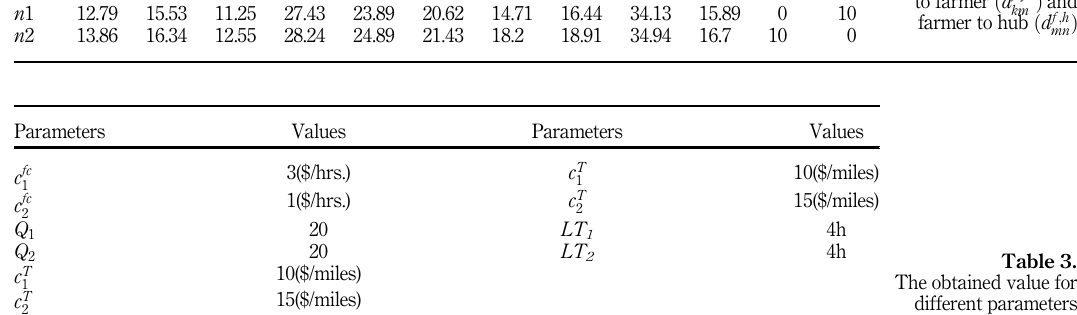
Table 2. Distance from farmer